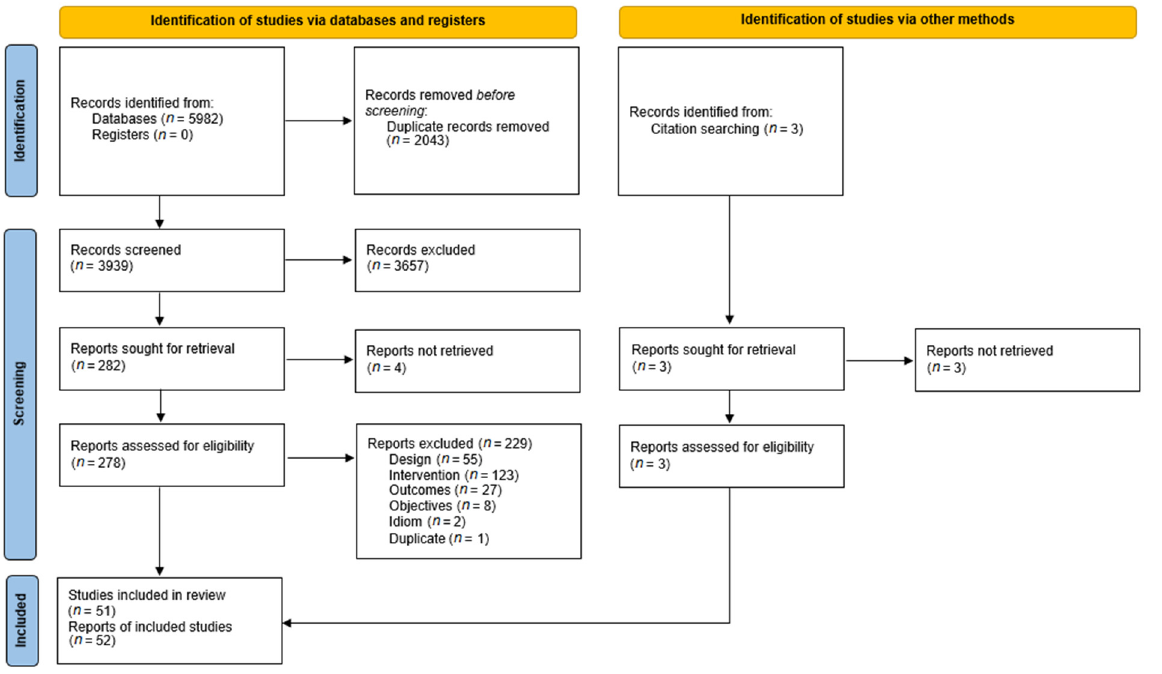
Figure 1. PRISMA flow diagram of the study selection process.